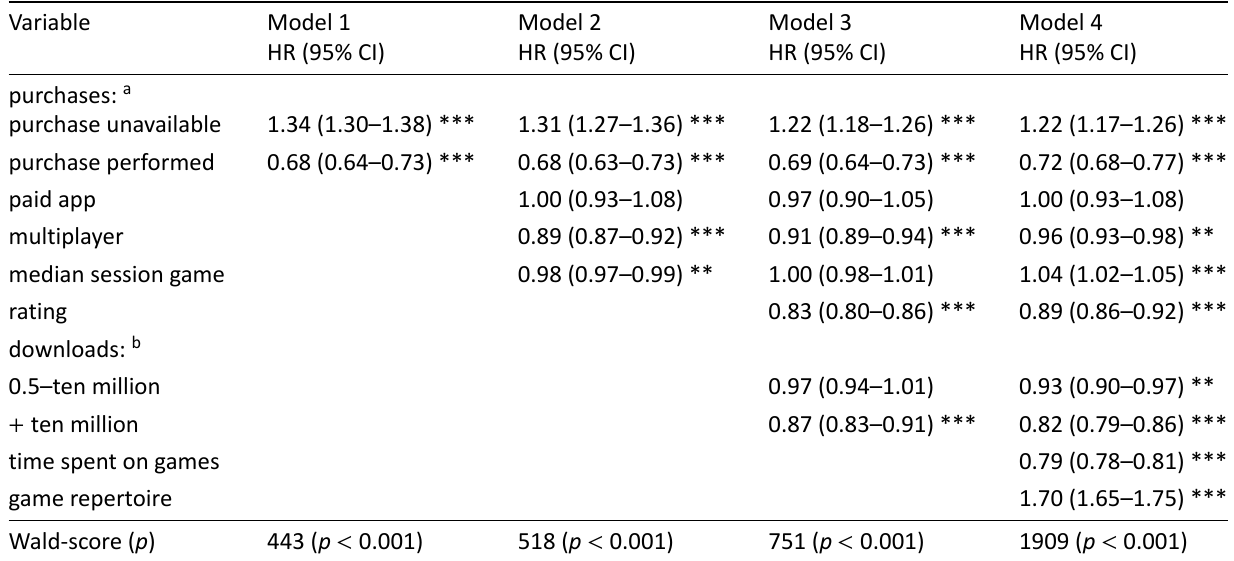
Table 1. Estimated parameters of Cox regression with time-dependent